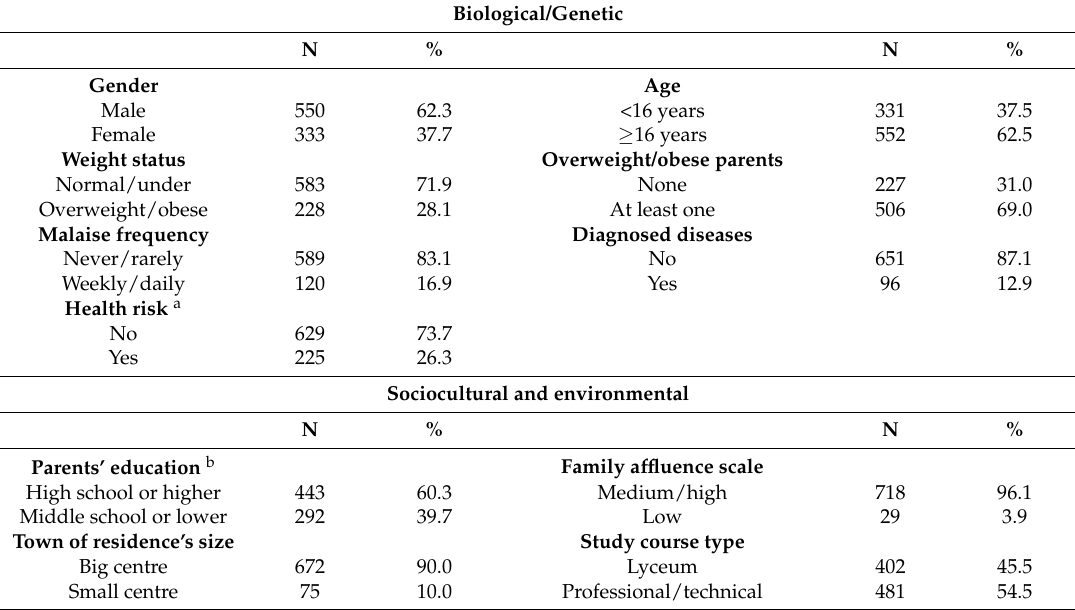
Table 1. Descriptive statistics of possible fitness level determinants in adolescents from the ASSO project (N =